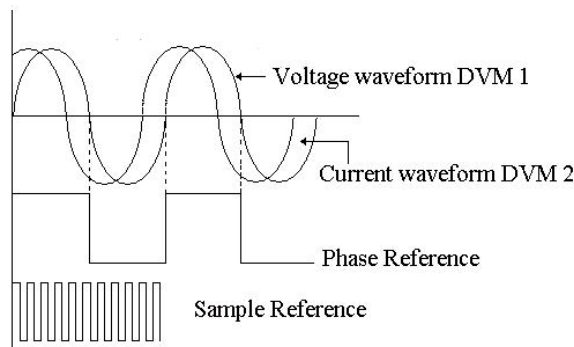
Fig. 2. Synchronization pattern of the